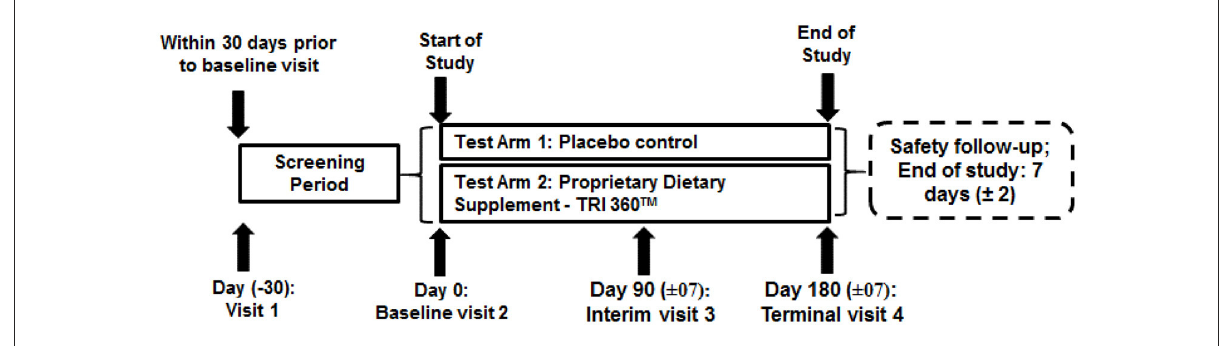
FIGURE1 Schematic diagram of study